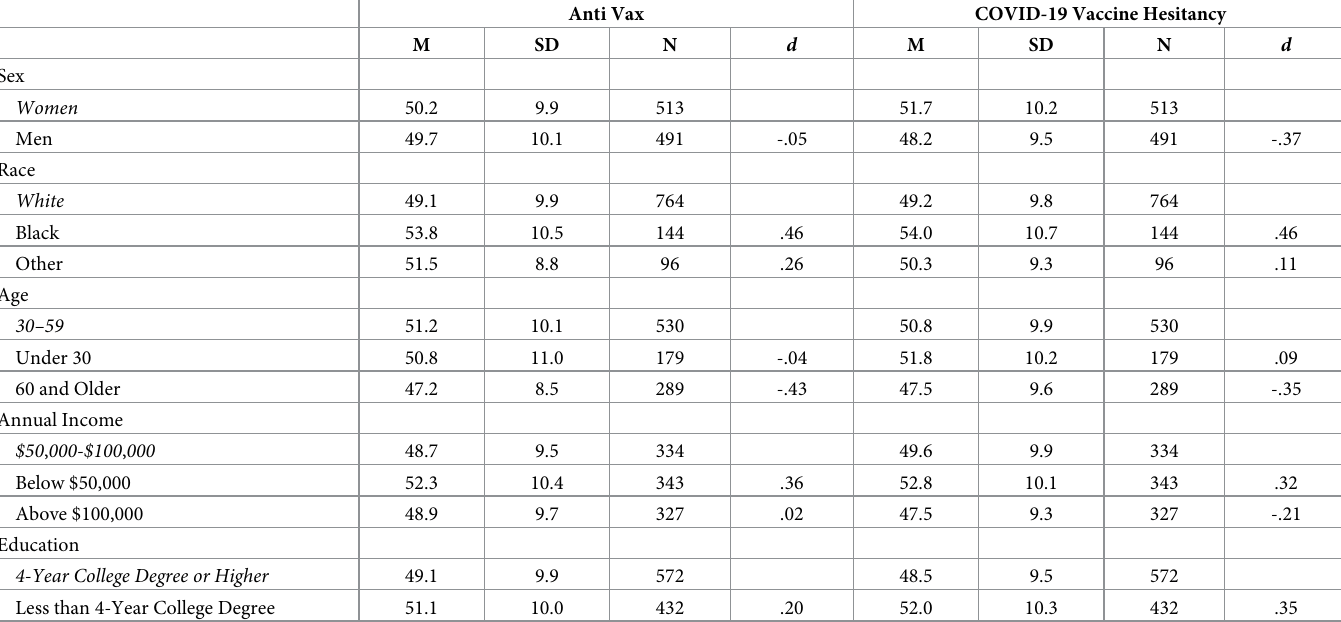
Table 5. Descriptive statistics and group differences in vaccine outcomes in fall